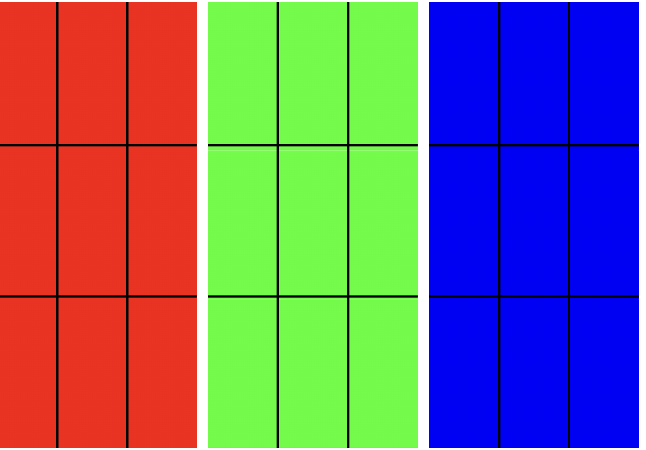
Figure 10. Segmentation diagram of the backlight panel measurement mode of iPhone X smart mobile device, and measured by UPRtek MK350N Plus, and then further corrected the color.